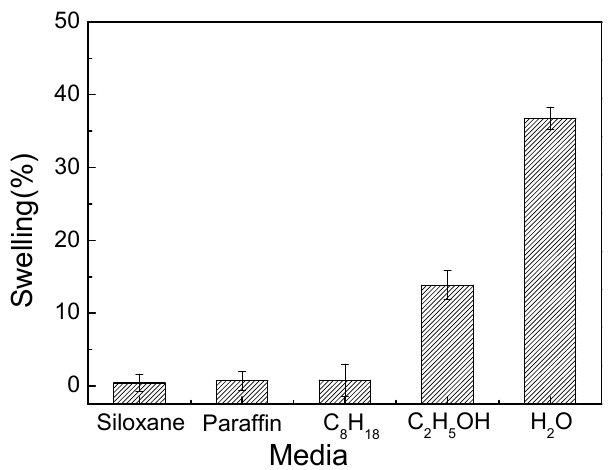
Figure 4. The swelling of viscose in different media.